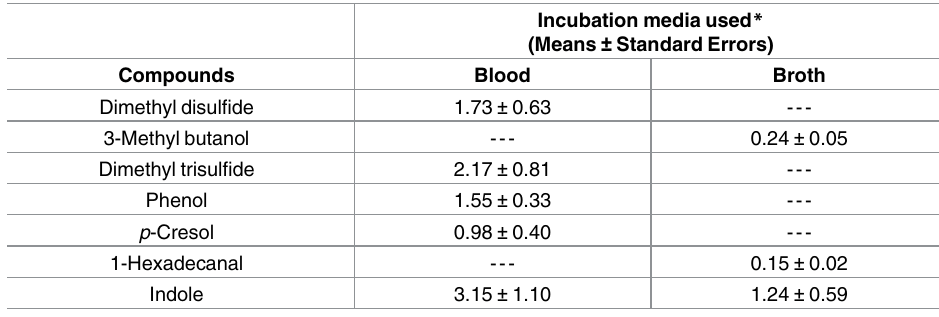
Table 1. Hourly absorption rates (ng) of solid phase microextraction of volatiles releasedfrom five bacteria incubated with blood or broth for 72 hours).